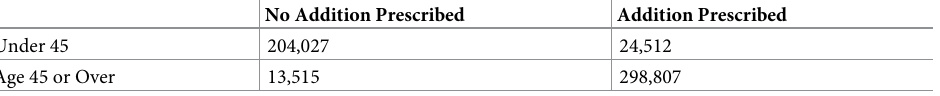
Table 2. Contingency table comparing the frequency of addition prescribing for EMR patients under age 45 and those age 45 and